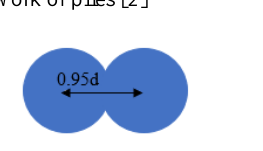
Fig. 2. Geometry of clumps used in DEM simulation